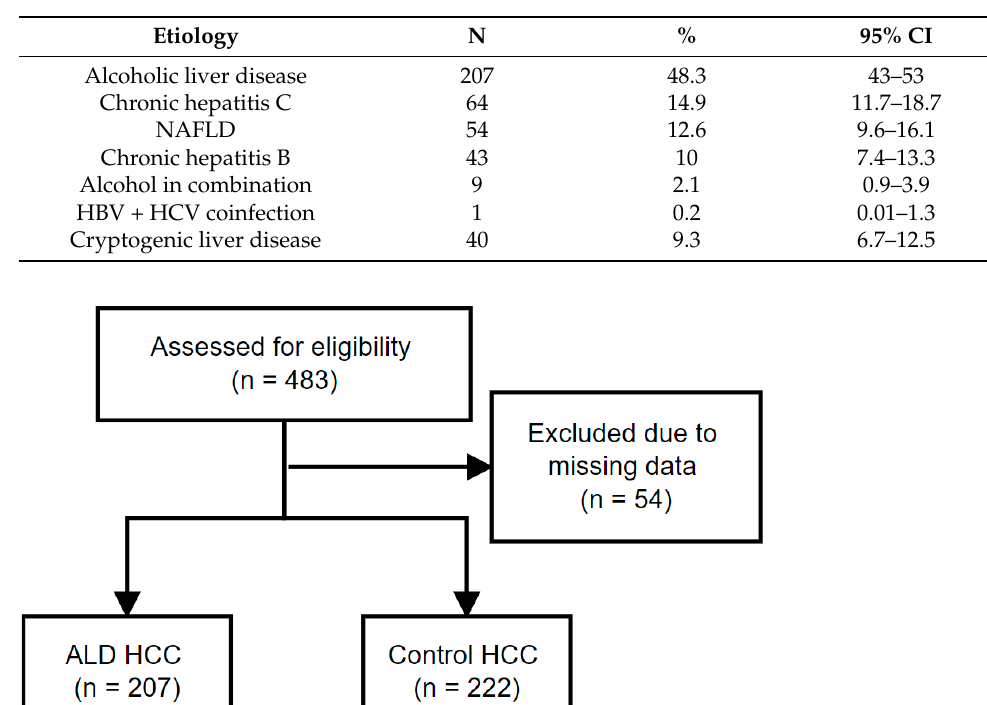
Table 1. Etiology of chronic liver disease.